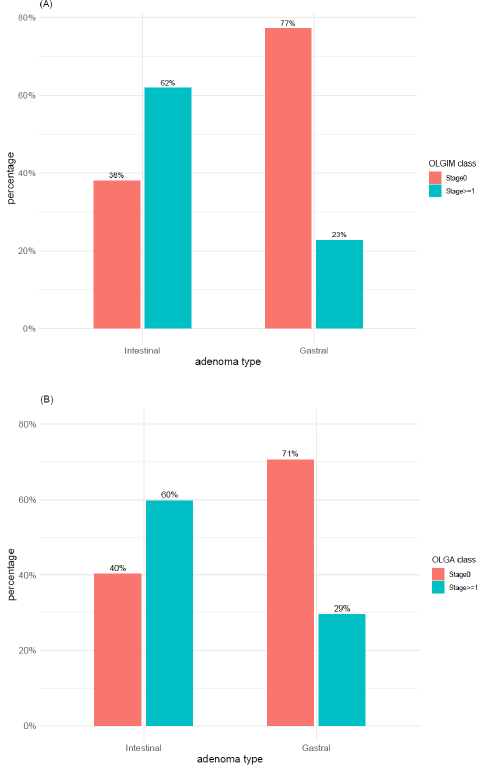
Figure 13. Distribution of ( A ) intestinal metaplasia and ( B ) atrophy within intestinal and gastral adenoma types according to OLGIM and OLGA classes (stage 0 vs. stages 1–4). When analyzing the distribution of OLGIM and OLGA low-/high-risk classes within intestinal-type and gastric-type adenomas, the differences between the adenoma-types previously detected (Figure 13) seemed to be lost. Indeed, almost all cases belonged to the low-risk group (Figure 14A,B).